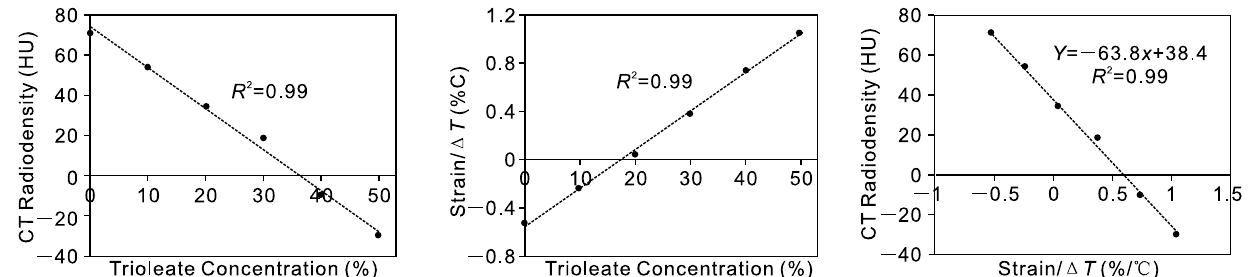
Figure 2 Correlation between parameter k , CT radiodensity and fat content [35].